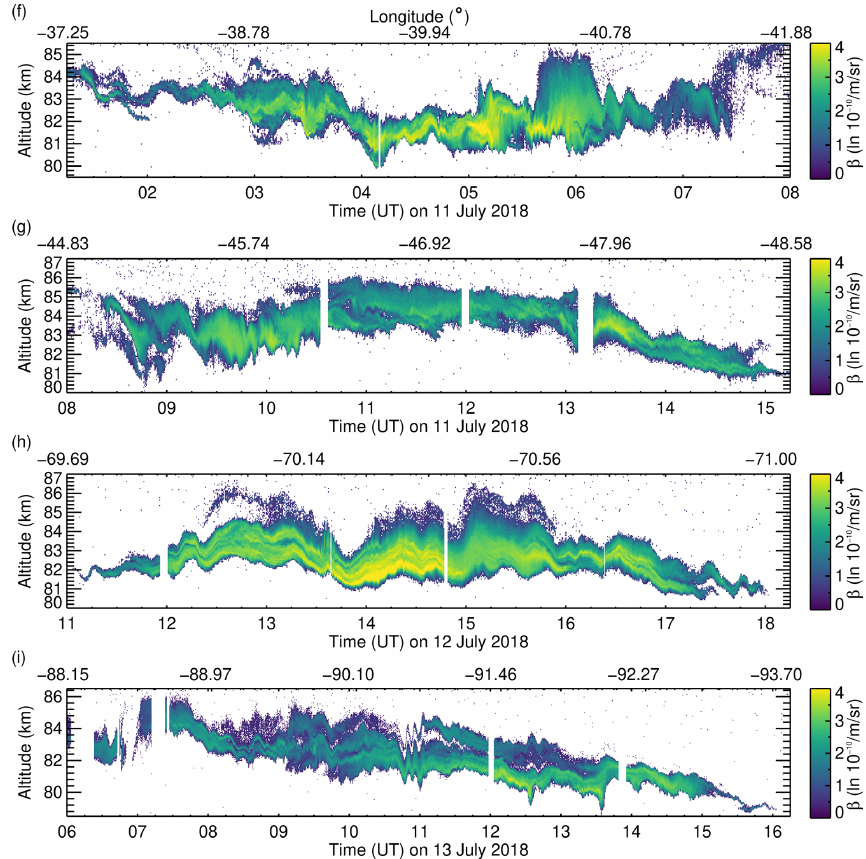
Figure 7. Part II of PMC altitude–time sections which are part of the PMC Turbo BOLIDE